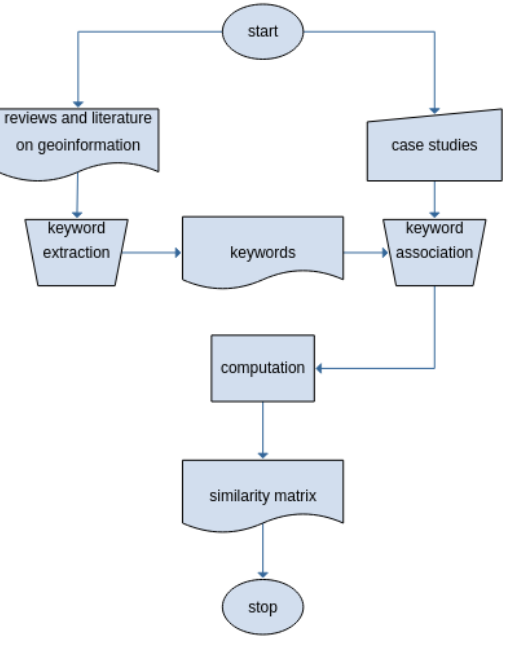
Figure 1. Depiction of the workflow